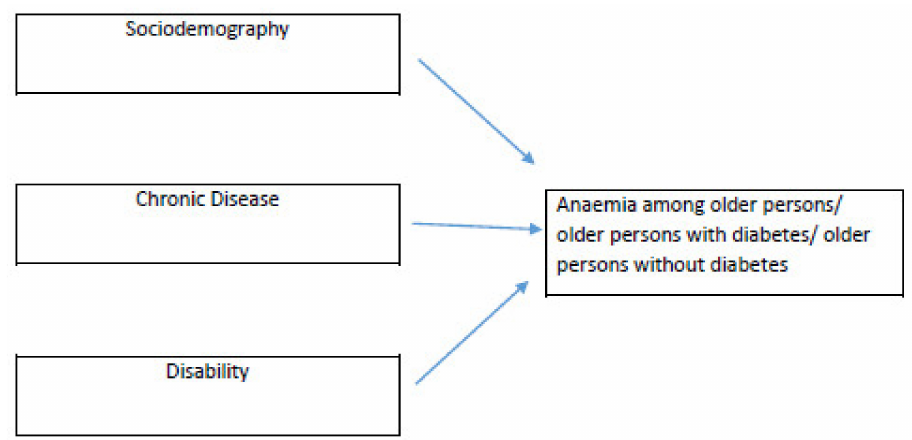
Figure 1. Conceptual framework predicting anemia based on socio-demography, chronic disease and disability among older